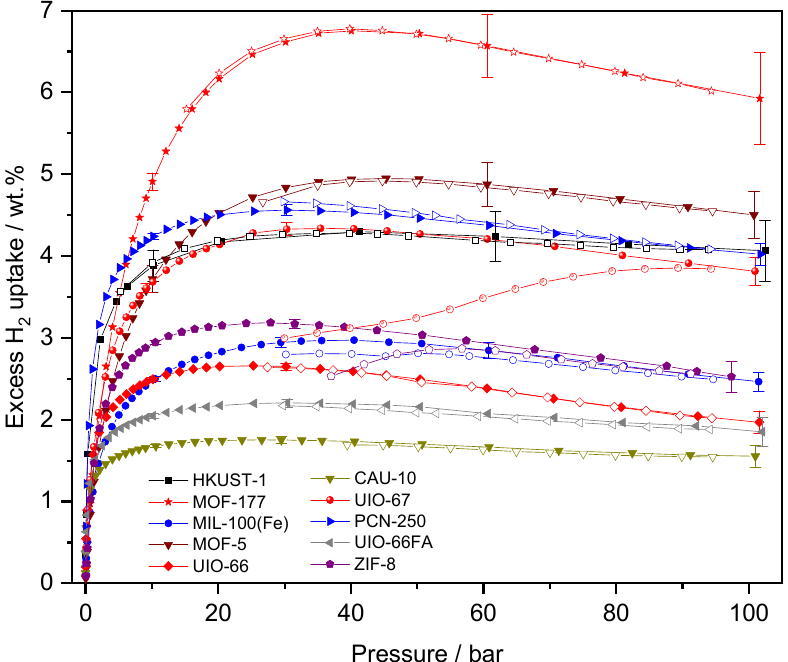
Figure 4. Excess hydrogen adsorption/desorption isotherms for MOFs at 77 K. Desorption steps were plotted as open symbols.